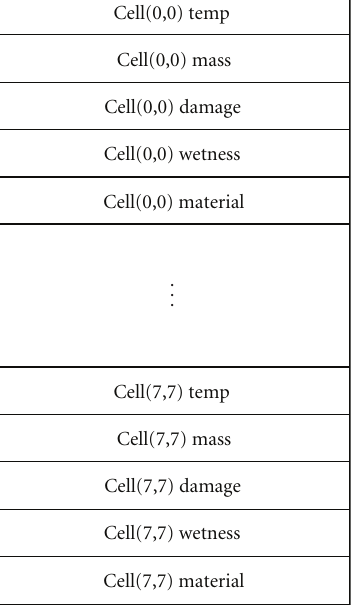
Figure 2: Chromosome for fire event.